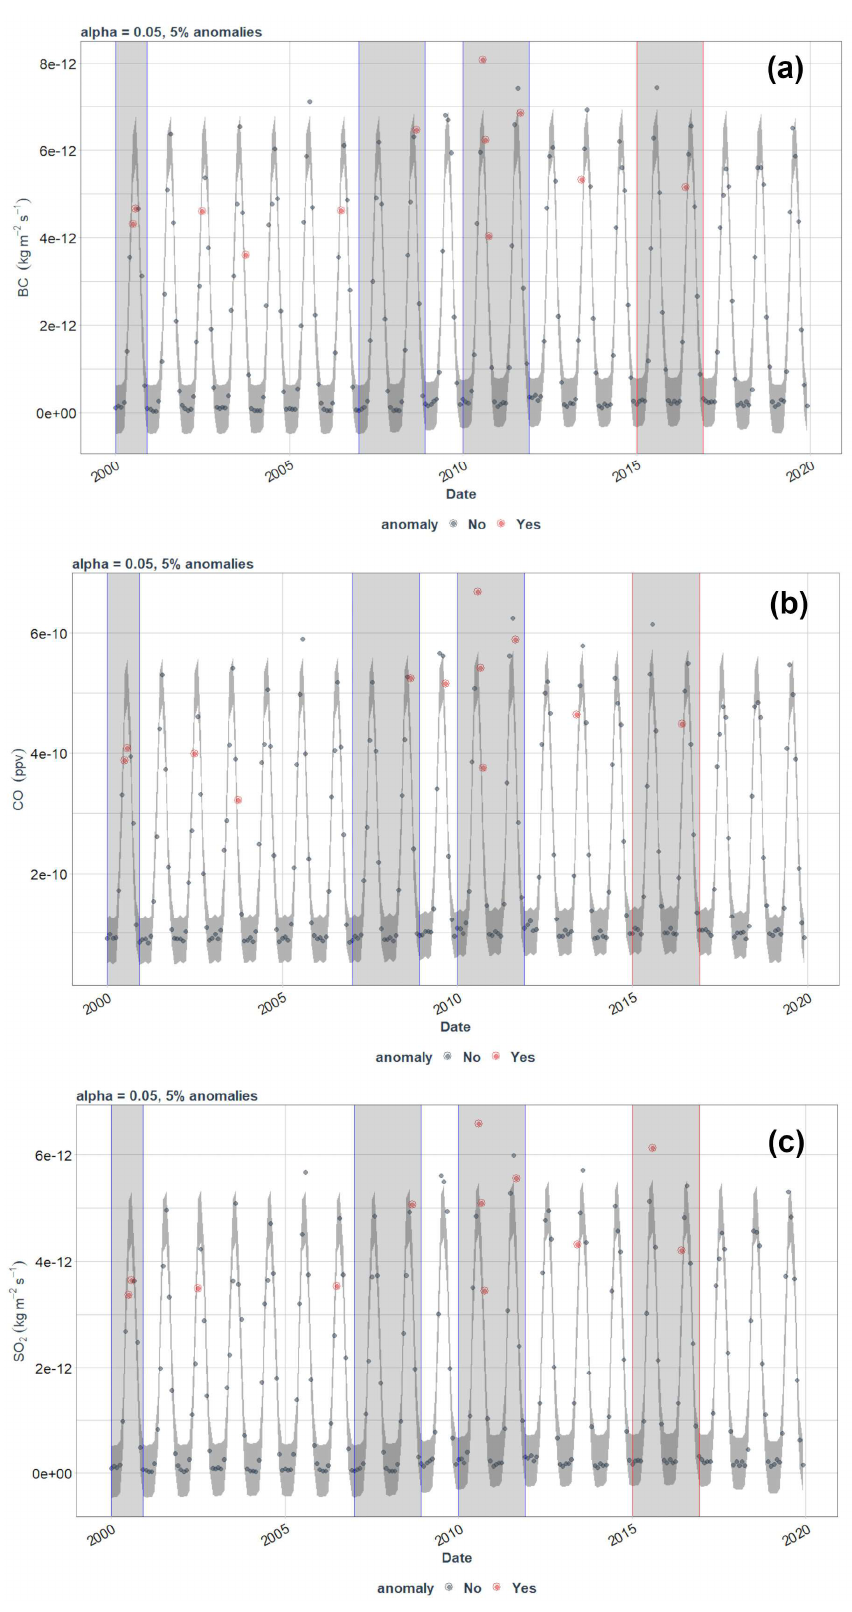
Figure 3. Interannual variability and emissions anomalies detected by generalized extreme studen- tized deviate (GESD) from 2000 to 2020. ( a ) Black carbon (BC), ( b ) carbon monoxide (CO), and ( c ) sulfur dioxide (SO 2 ).